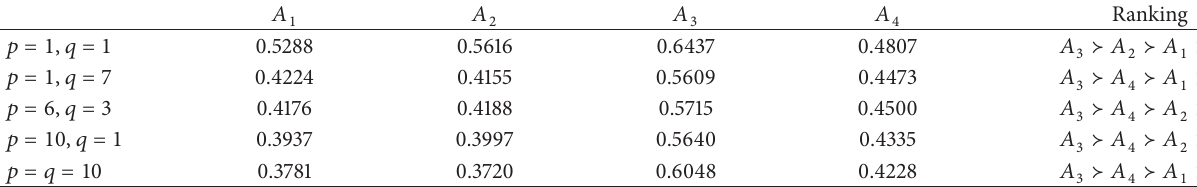
Table 4: Score values obtained by the IIFGWHM operator and the rankings of Districts.